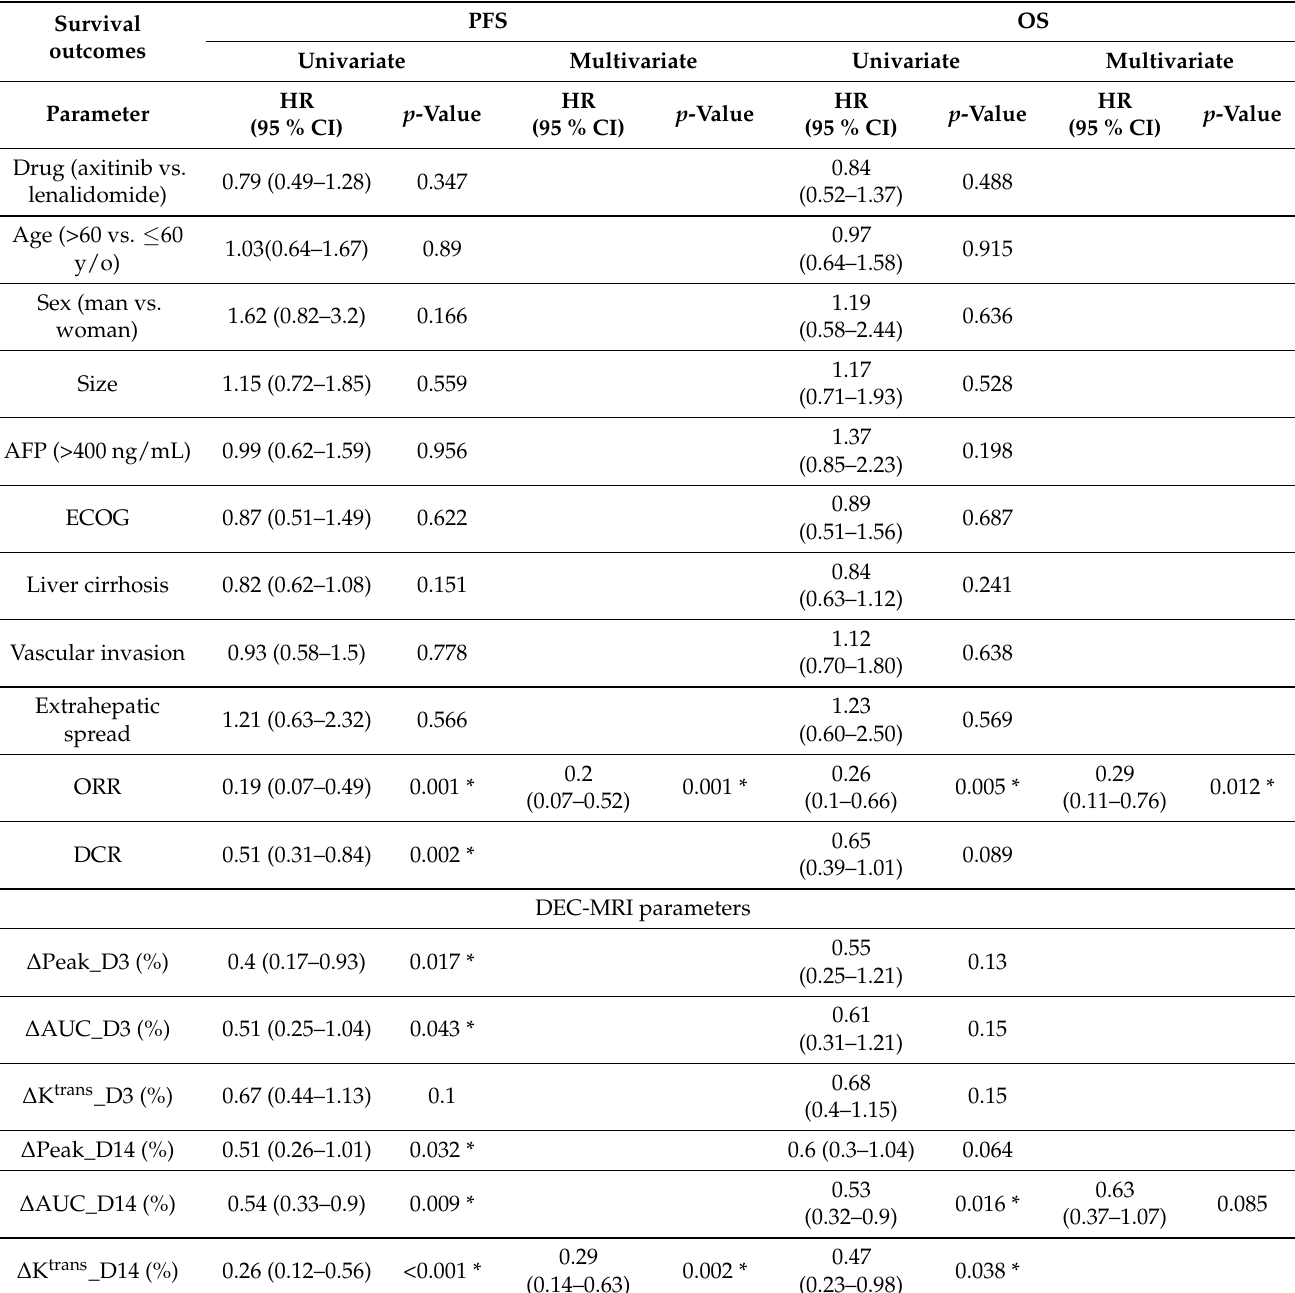
Table 3. Factors associated with PFS and OS based on univariable and multivariable